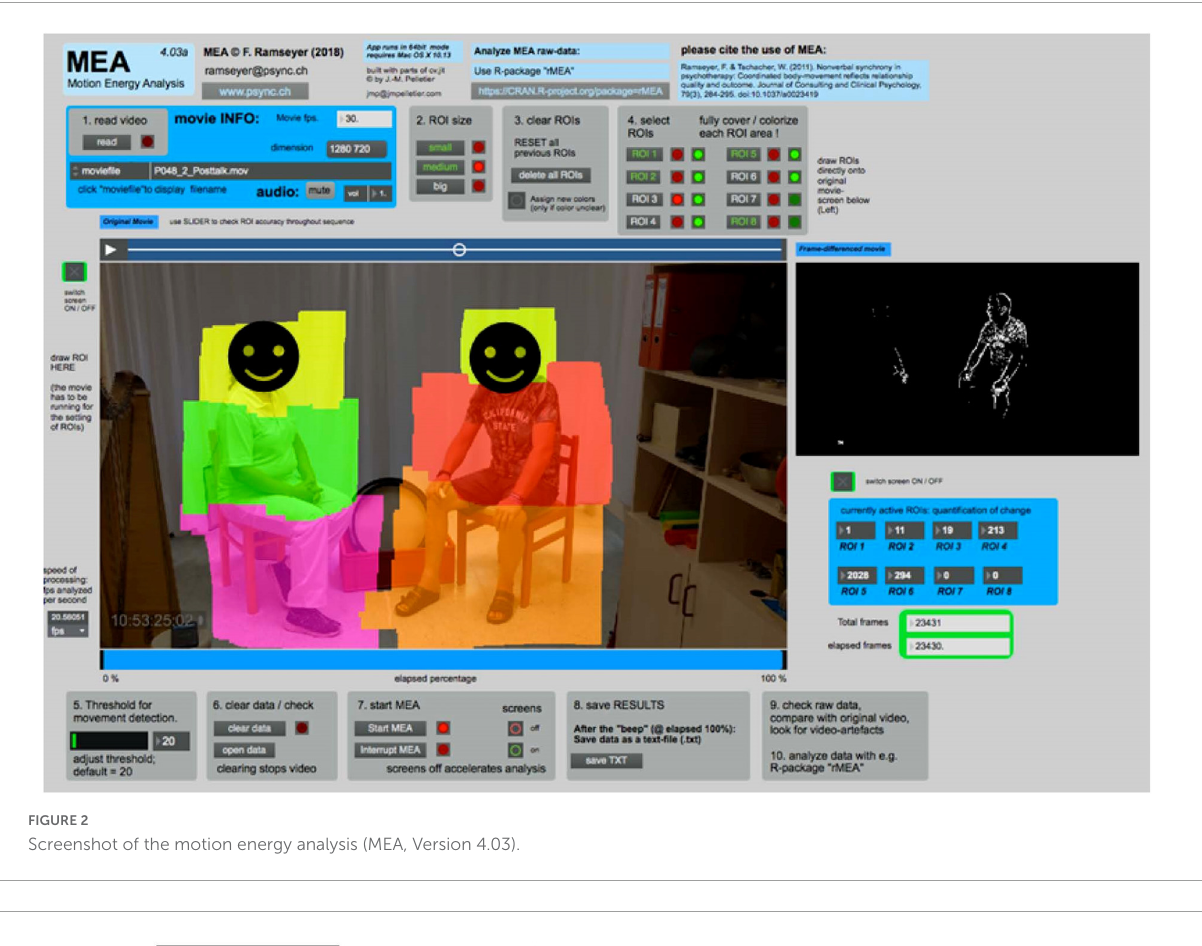
FIGURE2 Screenshot of the motion energy analysis (MEA, Version 4.03).